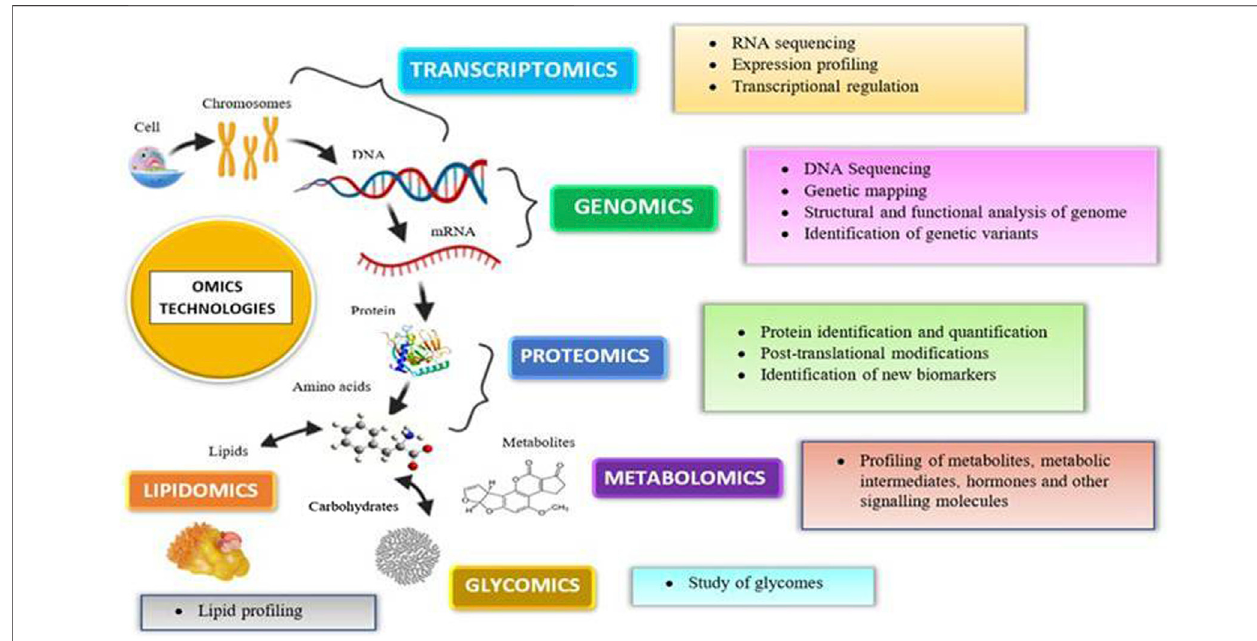
FIGURE 4 | Various omics approaches utilized today for an assessment of nanotoxicity evaluations.